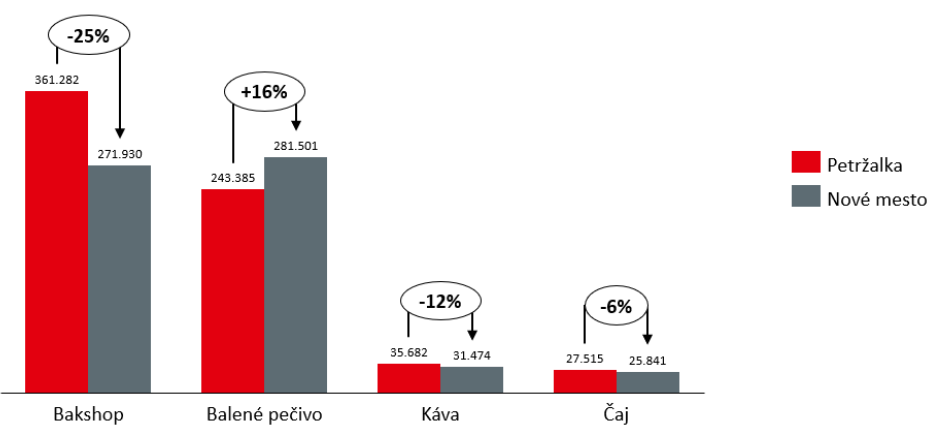
Figure 14. Quantity of units sold in Petržalka and Nové Mesto nad Váhom branches for the whole category of confectionery and individual subcategories for the period: 10 November 2020–31 Janu- ary